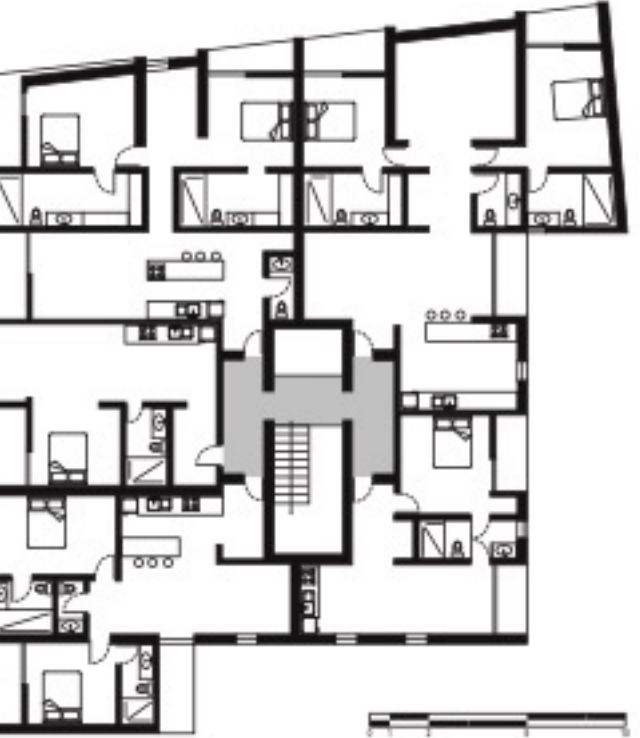
Figure 11. Example of lack of appropriation space and open circulation in study case number 1 “Mexicaltzingo 565”. Source own elaboration.